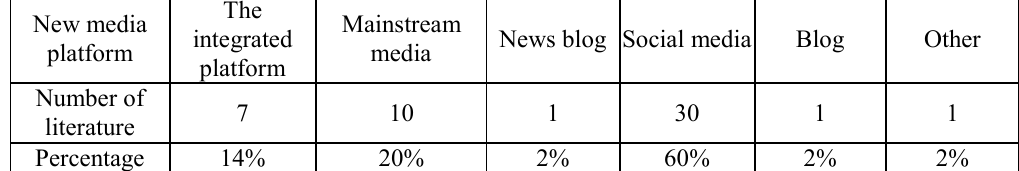
Table 1 – Distribution of foreign new media platforms involved in China Image